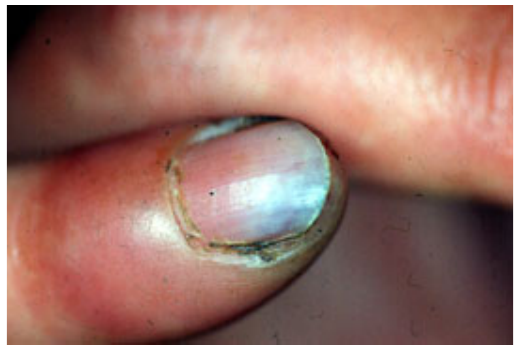
Figure 13: Edema and erythema in the ungual